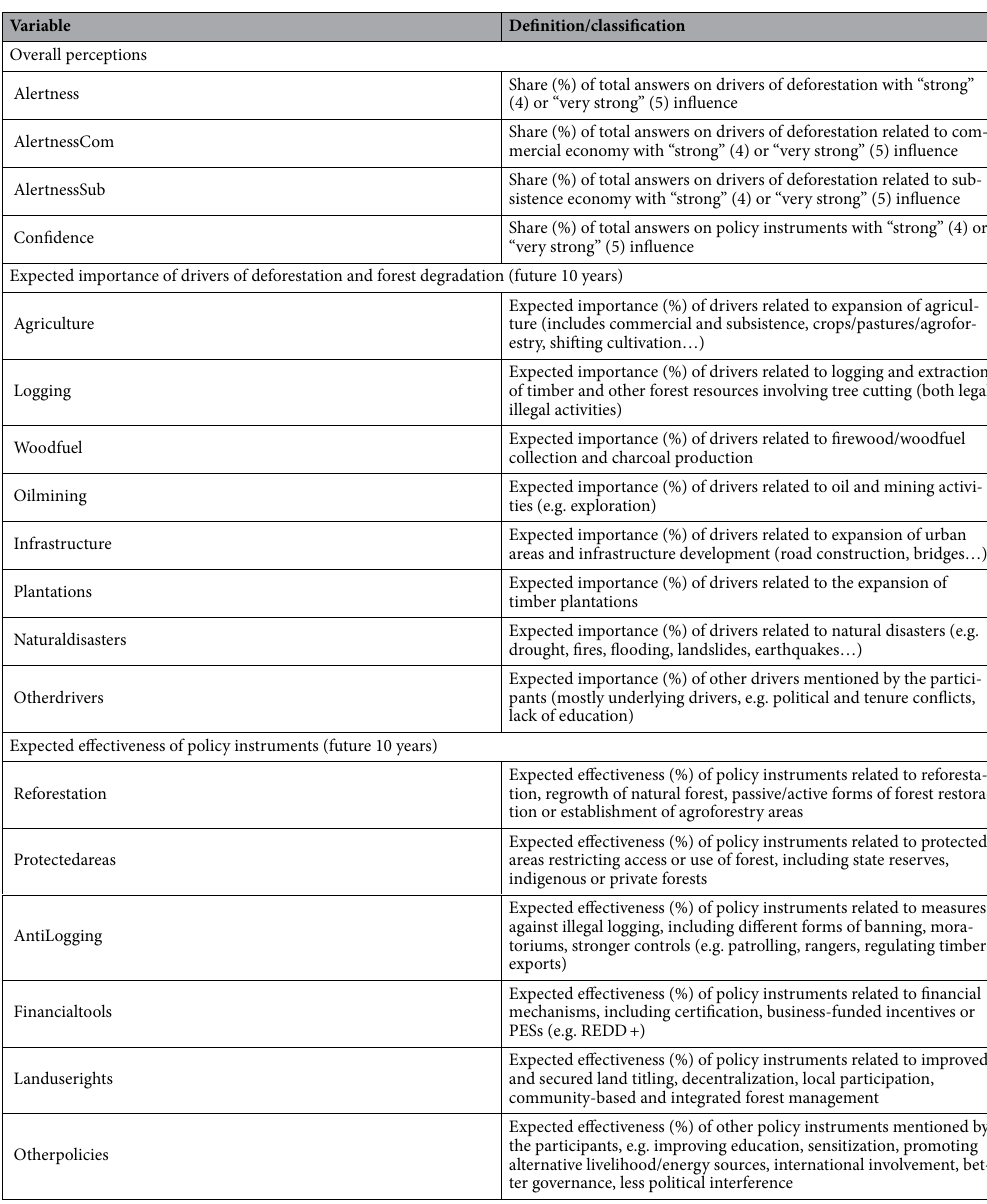
Table 2. Variables included in the statistical analysis and their definition (observation unit: